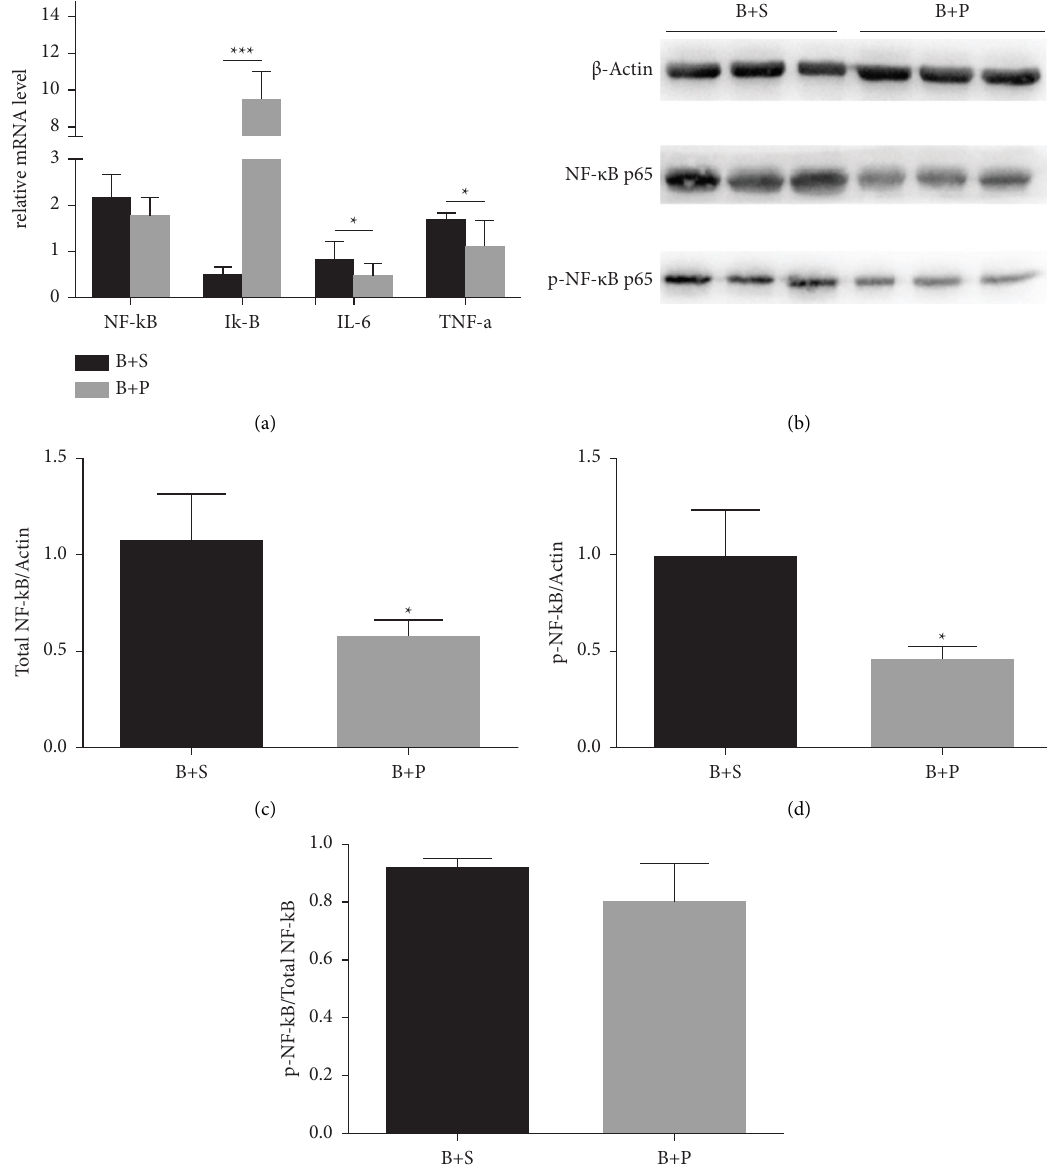
Figure 7: Efects of blue light on NF- κ B activation. (a) Real-time PCR for the expression of cytokines and infammatory factors. Te production of IL-6 and TNF decreased signifcantly after PDTC treatment ( ∗ P < 0 . 05), while the expression of I κ -B upregulated signifcantly ( ∗∗∗ P < 0 . 001). (b) Efects of blue light on the activation of NF- κ B in corneas are evaluated by Western blot analysis using β -actin as a loading control. (c, d) PDTC treatment decreased the expression of total NF- κ B p65 and phosphorylated NF- κ B p65 ( ∗ P < 0 . 05). Te ratio of phosphorylated NF- κ B p65 to total NF- κ B p65 showed no signifcant